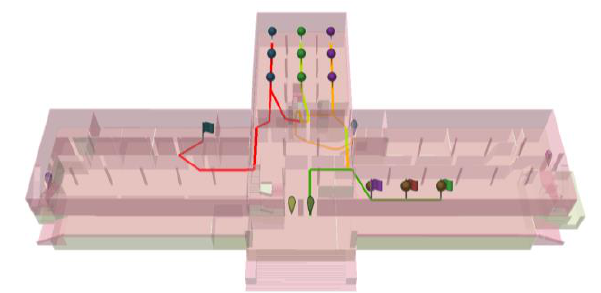
Figure 29. Generated Evacuation Second Floor Routes of